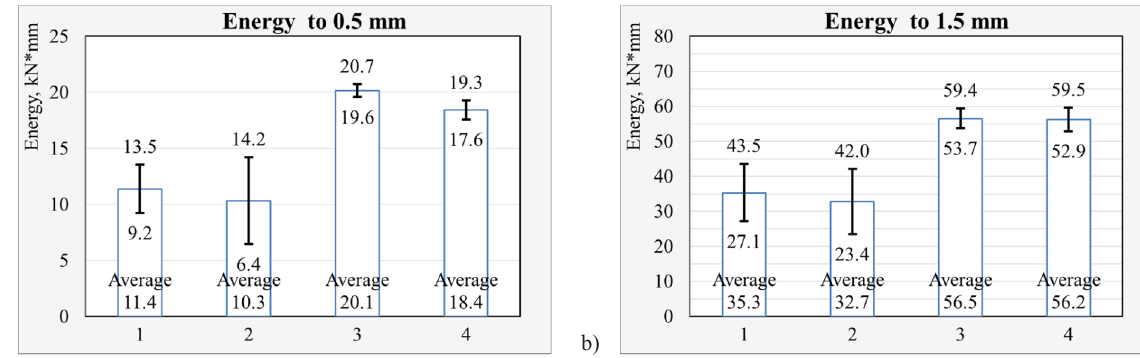
(b)a) Fig. 8. Energy spent reaching deflection equal to 0.5 mm (a), and 1.5 mm